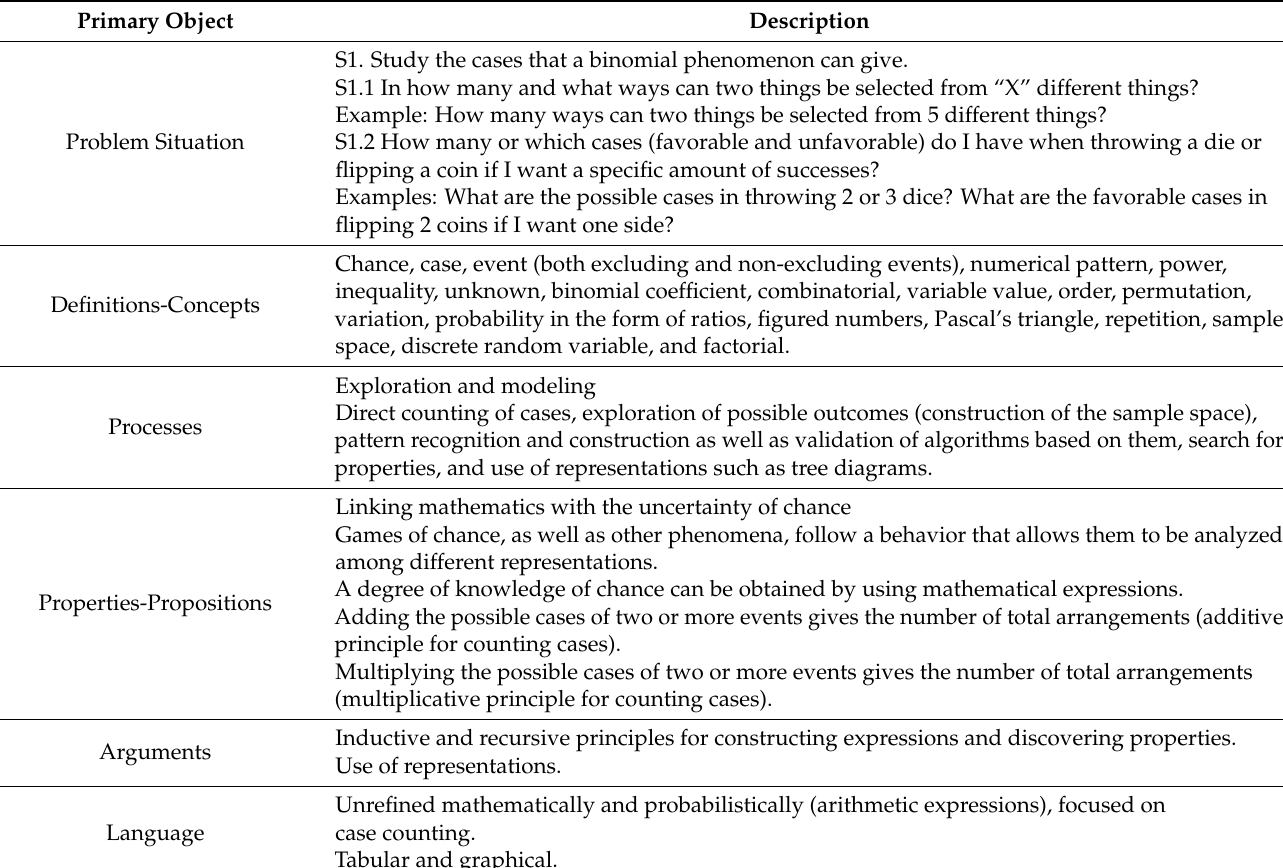
Table 12. Primary objects of the first meaning of binomial